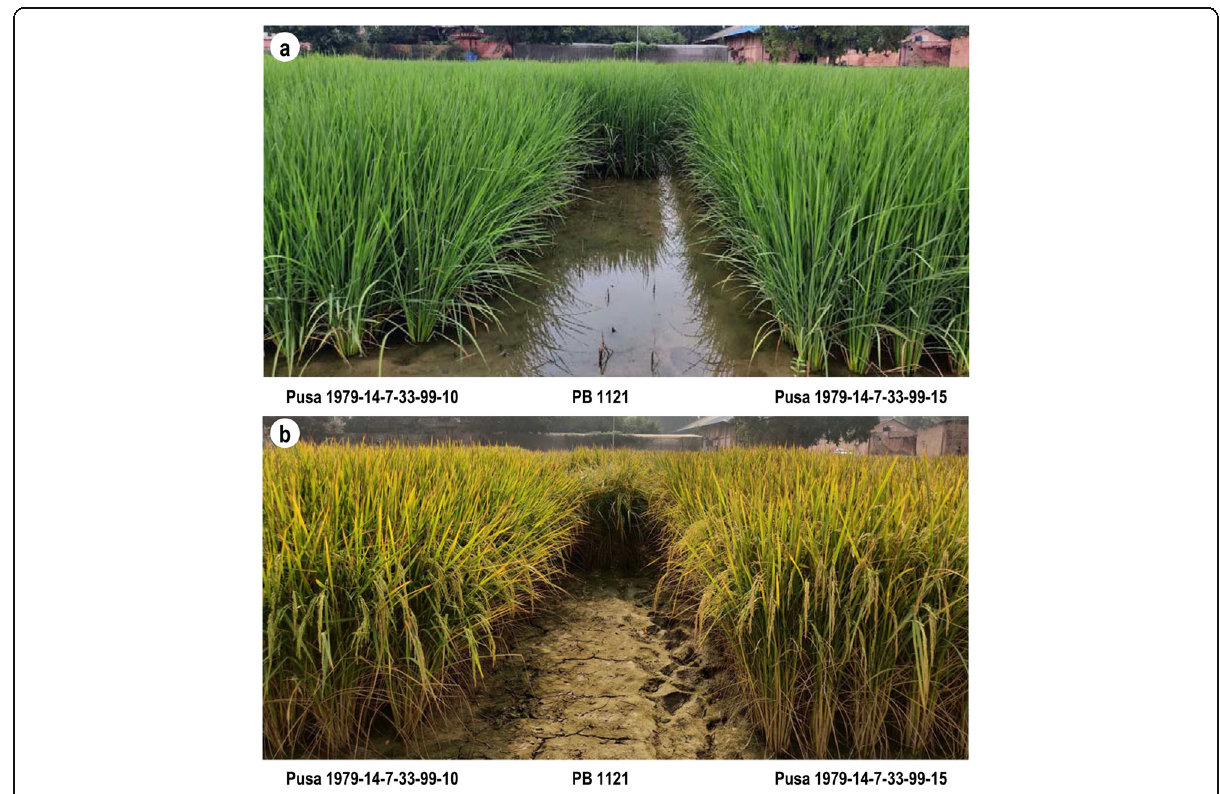
Fig. 7 Field view of the PB 1121 HT-NILs at ( a ) booting and ( b )